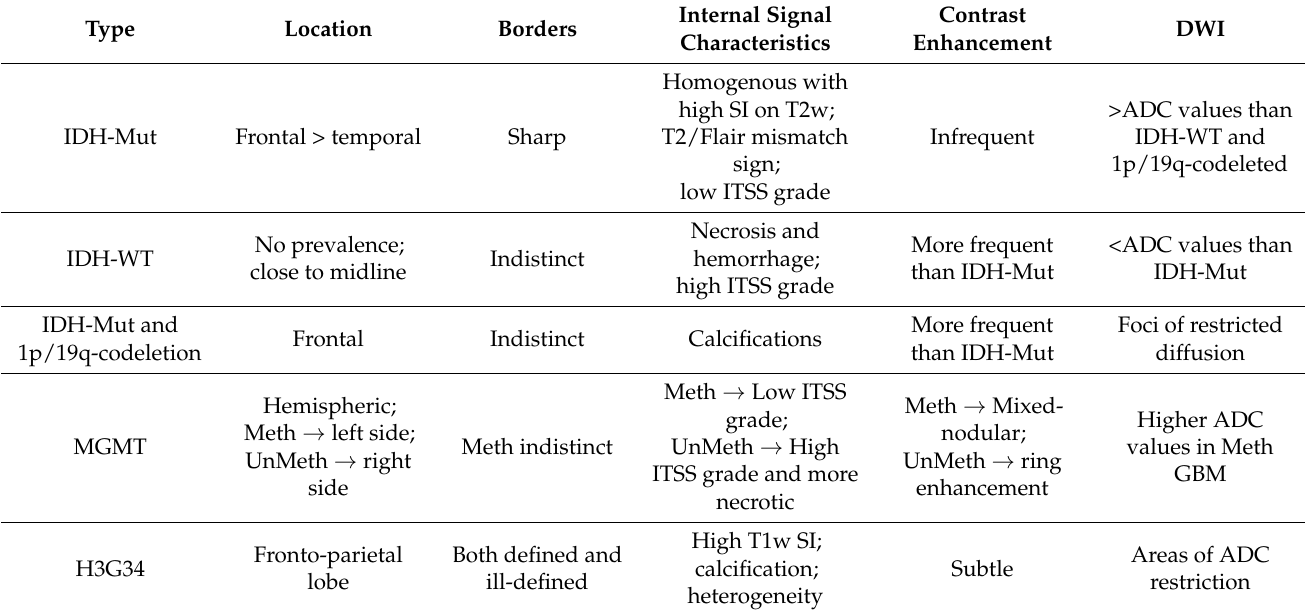
Table 1. The principal morphological MRI features associated with IDH groups, 1p/19q-codeletion, MGMT, and H3G34. SI, signal intensity; Meth, methylated; UnMeth, unmethylated; ADC, apparent diffusion coefficient; ITSS, intratumoral susceptibility